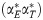
Theoretical and numerical bounds of the deviation factors.The black solid line represents the numerical Pareto frontier, and the red dotted lines represent the theoretical bounds of the deviation factors (αE*αT*).